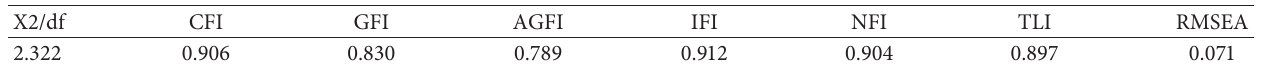
Table 2: Fit indexes of the model.